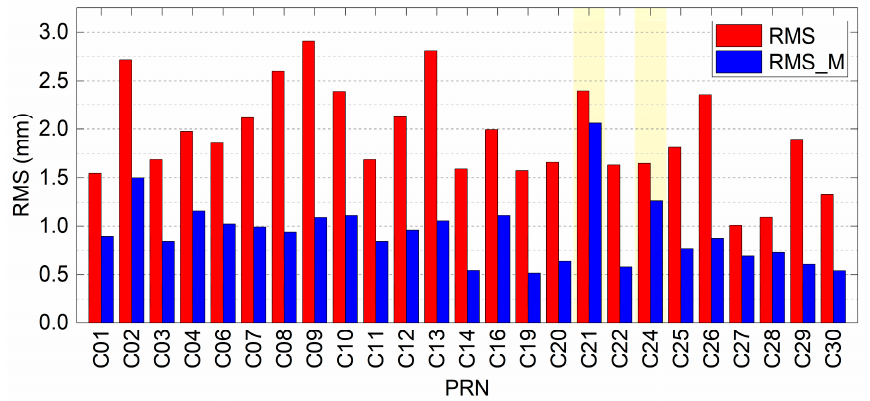
Figure 6. RMS of the original single-difference series and their series with multipath mitigation for the DOY 303 observed satellite.